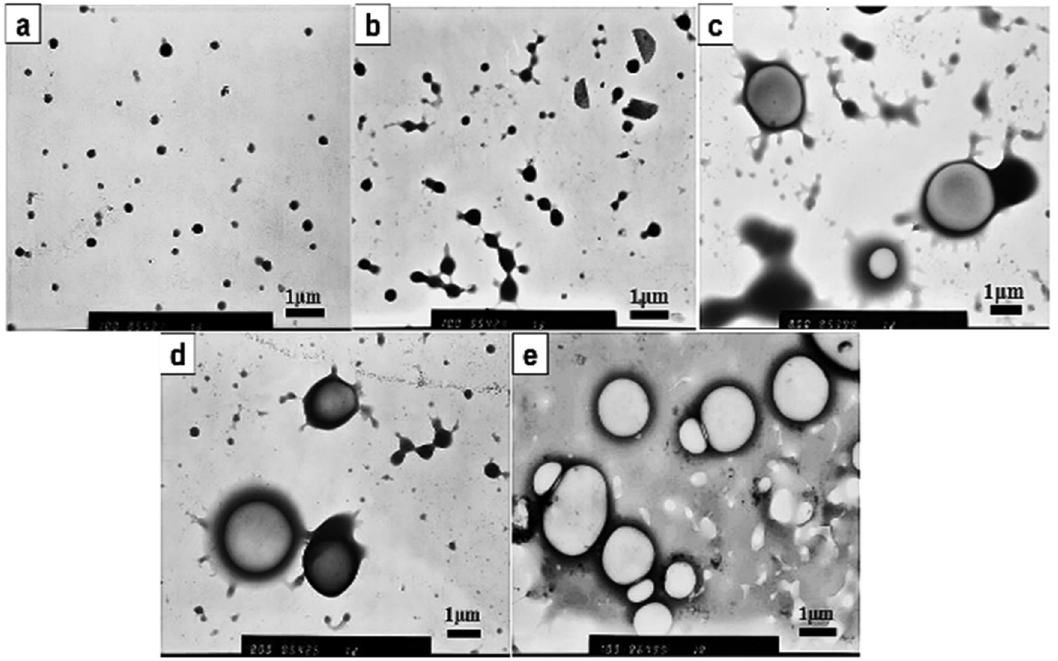
Figure 3: TEM images of aggregates formed from DSPE – PEG2k and PDLLA – MPEG micelle ( at a mass ratio of 0.001:1 ) mixed solutions at di ff erent mixing time: ( a ) 0 h, ( b ) 1 h, ( c ) 6 h, ( d ) 12 h and ( e ) 24